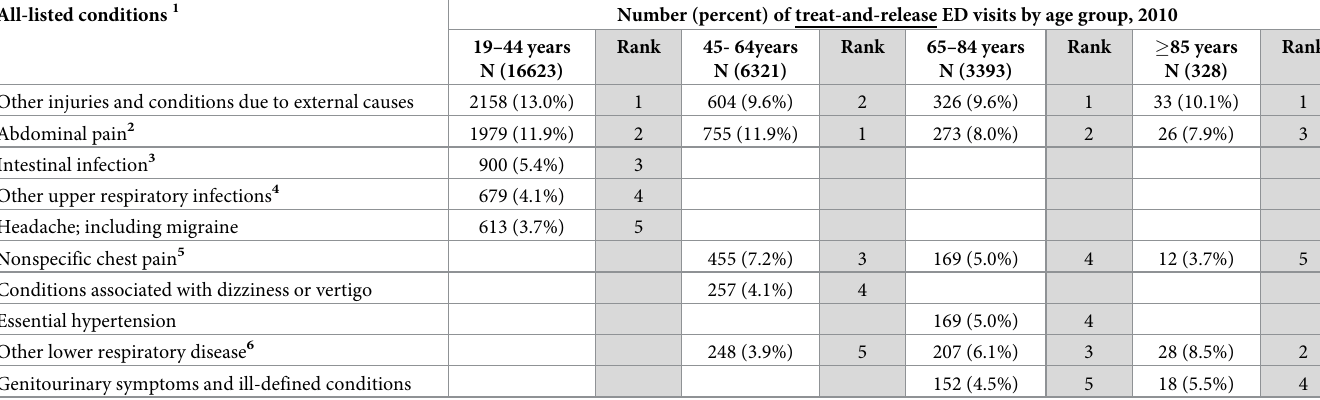
Table 5. Top listed conditions for adult treat- and release ED visits by age group,